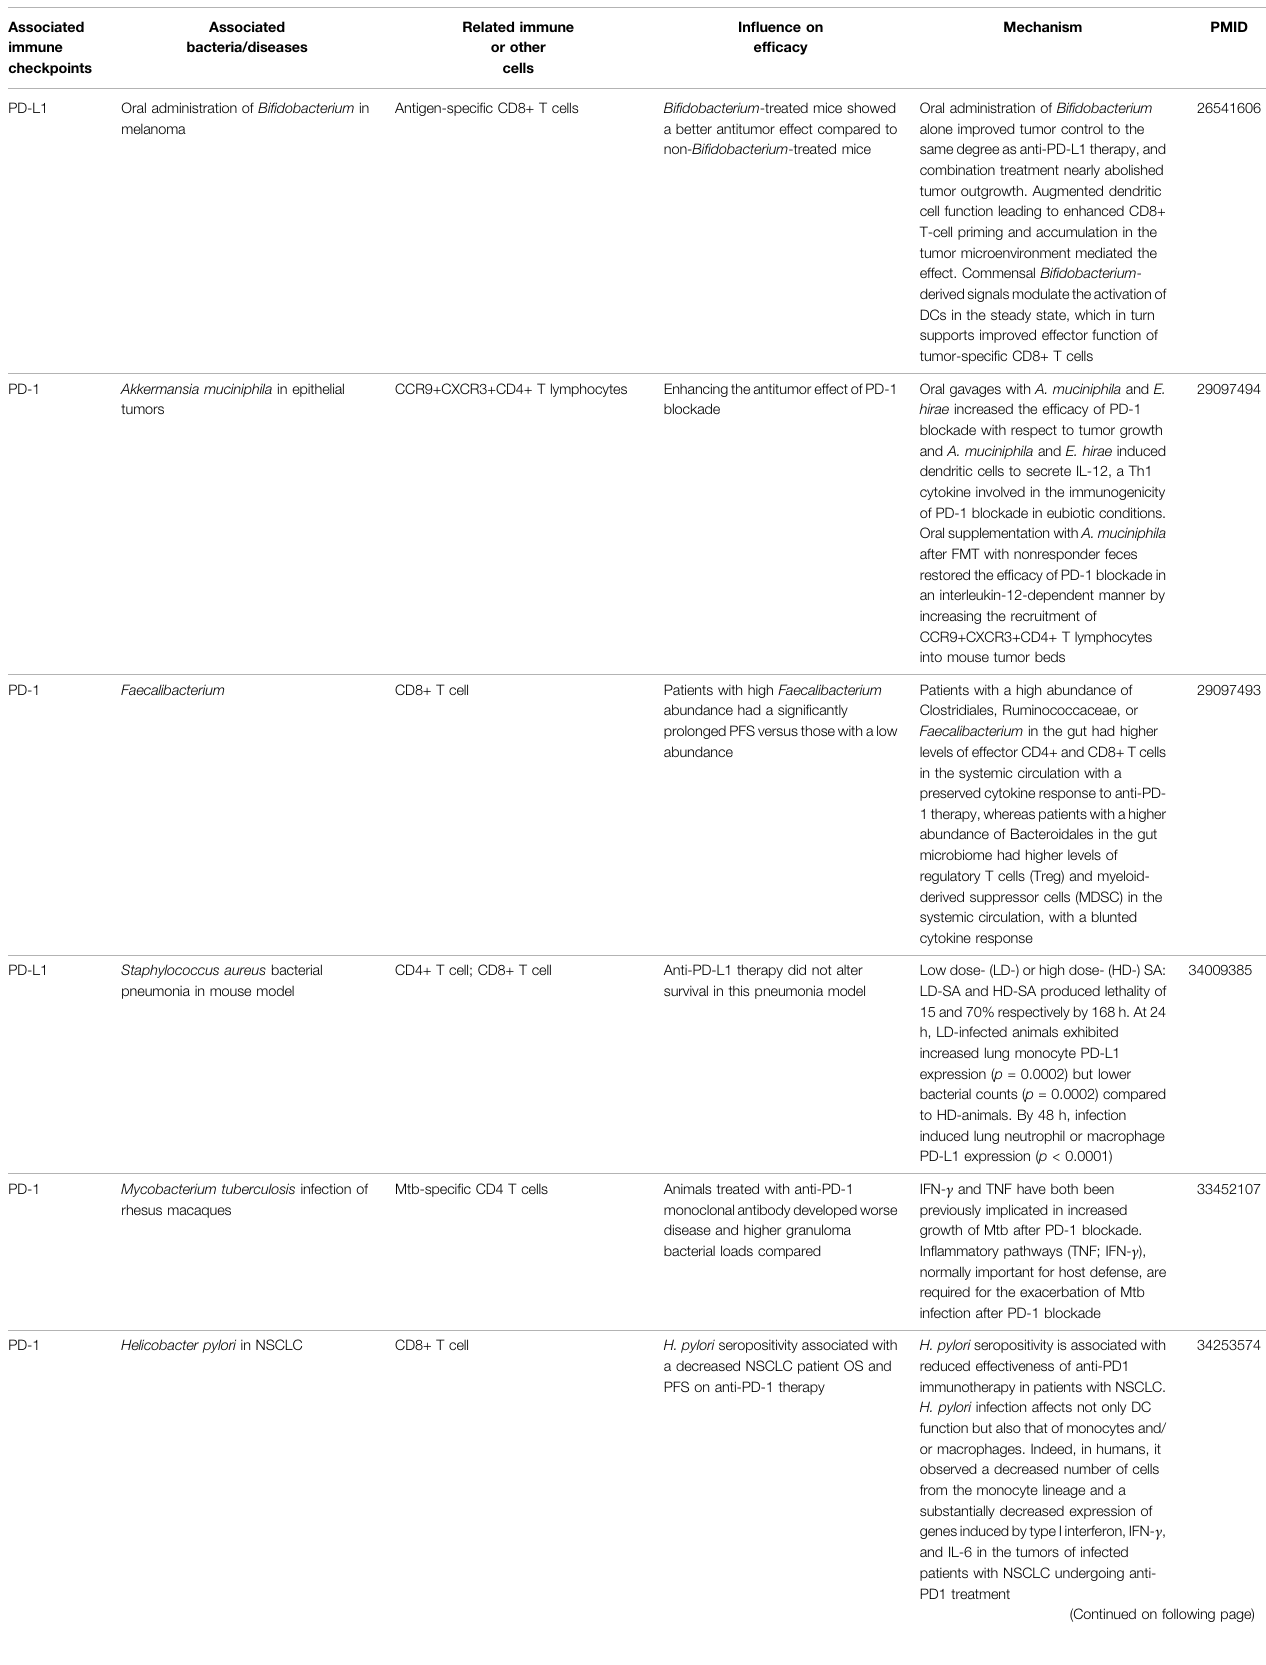
TABLE 2 | The role of immune checkpoints in bacteria-related diseases. Associated